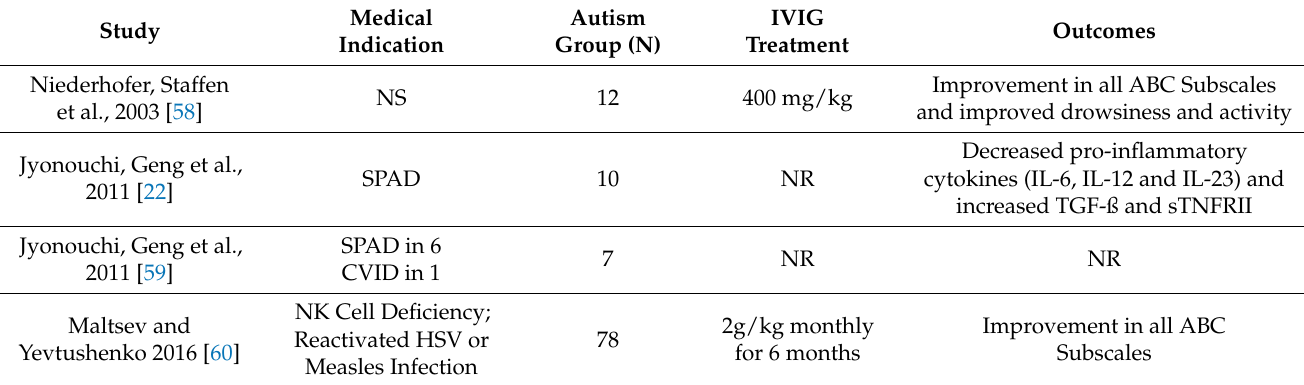
Table 3. Prospective Controlled Immunoglobulin G Treatment Studies in Autism Spectrum Disorder. Specific Polysaccharide Antibody Deficiency (SPAD); Common Variable Immunodeficiency (CVID); Aberrant Behavior Checklist (ABC); Not specified